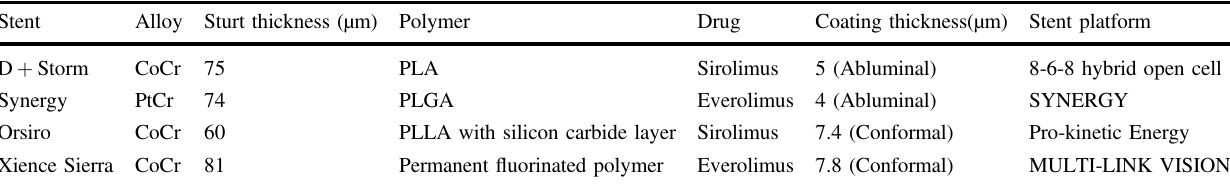
Table 1 Characteristics of drug-eluting stent Stent Alloy Sturt thickness (µm)